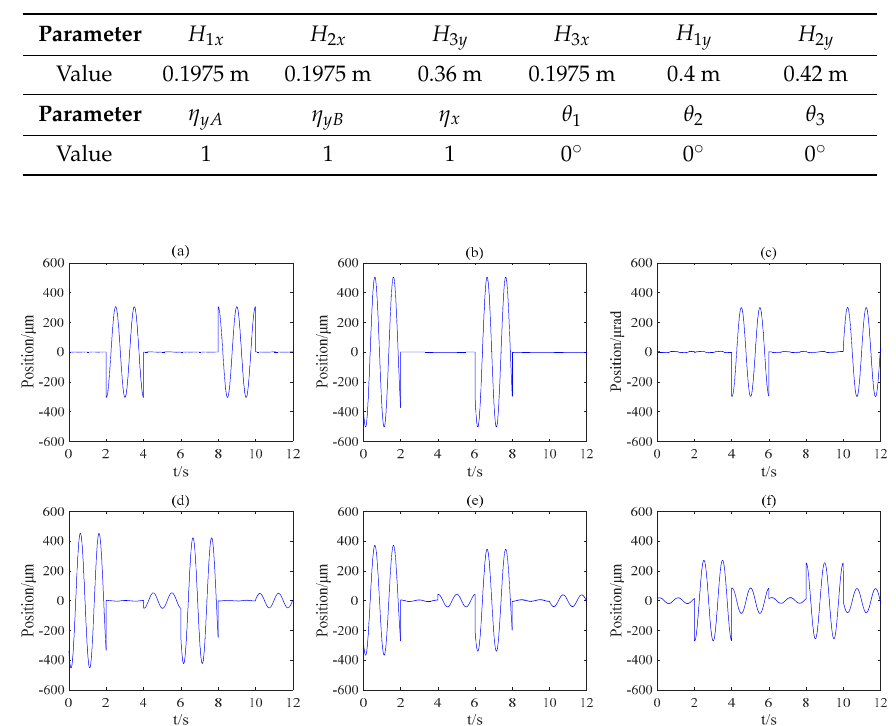
Table 1. The designed values of parameters in Hall sensor array.